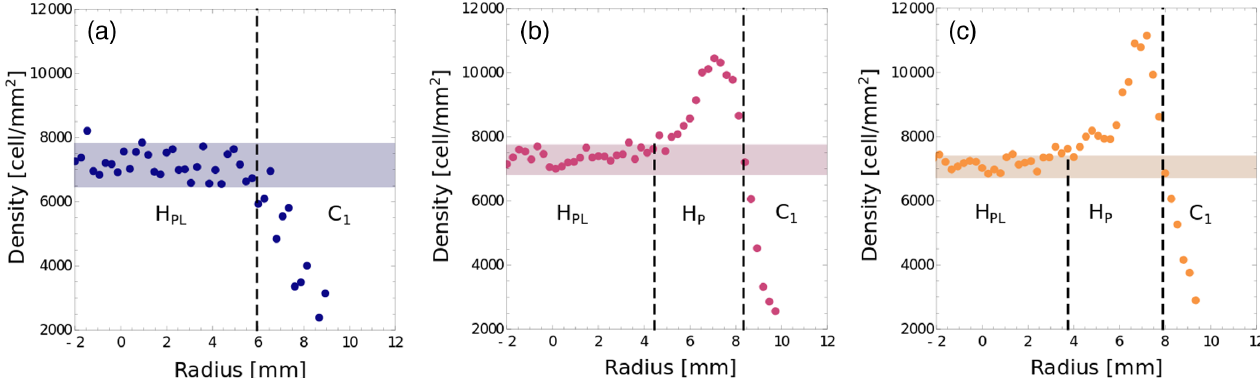
FIG. 7. Spatial dependence of the density in the cluster. (a) Cluster on the glass substrate, (b) cluster on 11 kPa PA gels, and (c) cluster on 5 kPa gels, showing very similar features to the cluster grown on 11 kPa gels. These colonies belong to two different series of data, in comparison to the ones shown in Fig. 1, but are mutually consistent. Horizontal lines represent 2 standard deviations around the mean cell density in the central region (2.3 mm radius). If the image segment is within those lines, it is considered as bulk. If the density of a given image segment is below the bottom line, the segment is considered as part of the edge region, and segments with density higher than the upper line are considered as part of the high-density ring.